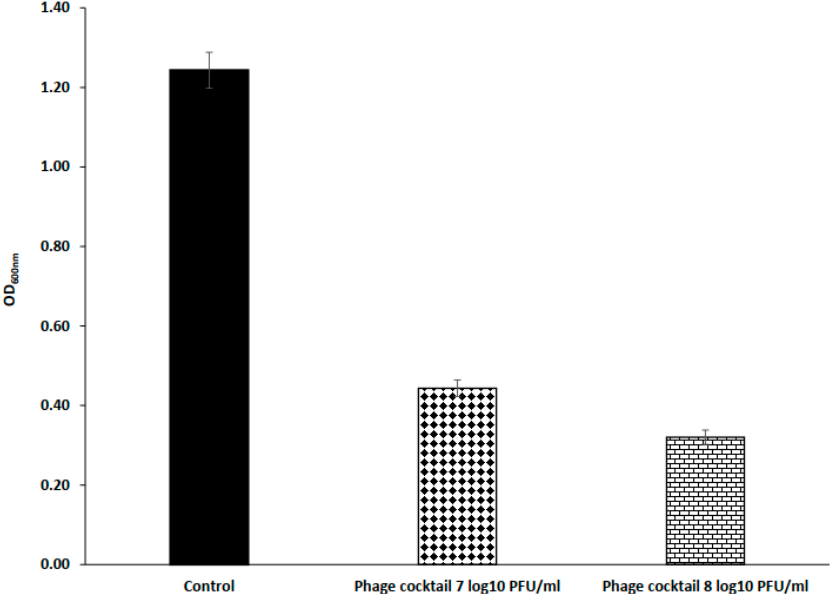
Figure 8. Effect of a phage cocktail on 72-h-old biofilm of S. Typhimurium EG.SmT3 in 96-well microplate. The values represent mean biofilm reduction with standard deviation of three replicates.